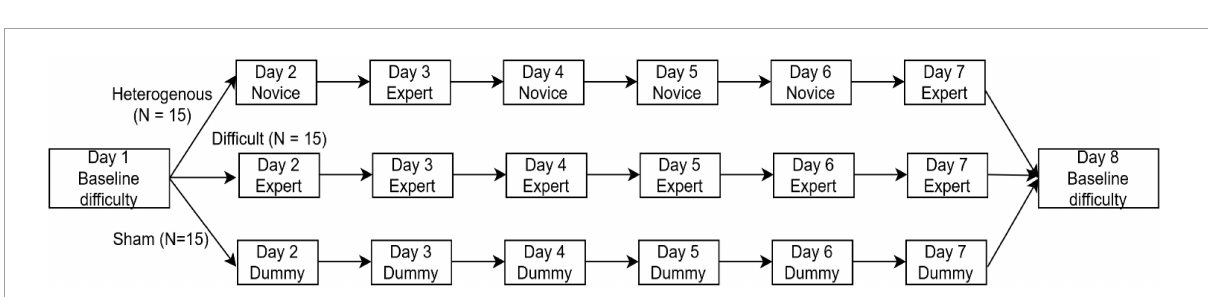
FIGURE2 Experiment Design of the study. Participants performed in a VR environment of Baseline difficulty on Day 1 and were equally and randomly divided into three between-subjects conditions: Heterogenous, Difficult, and Sham. Each between-subjects condition was 6 days long (from Days 2 to 7) and consisted of Novice, Expert, and Dummy VR environments. On Day 8, all participants were again asked to perform in a VR environment of Baseline